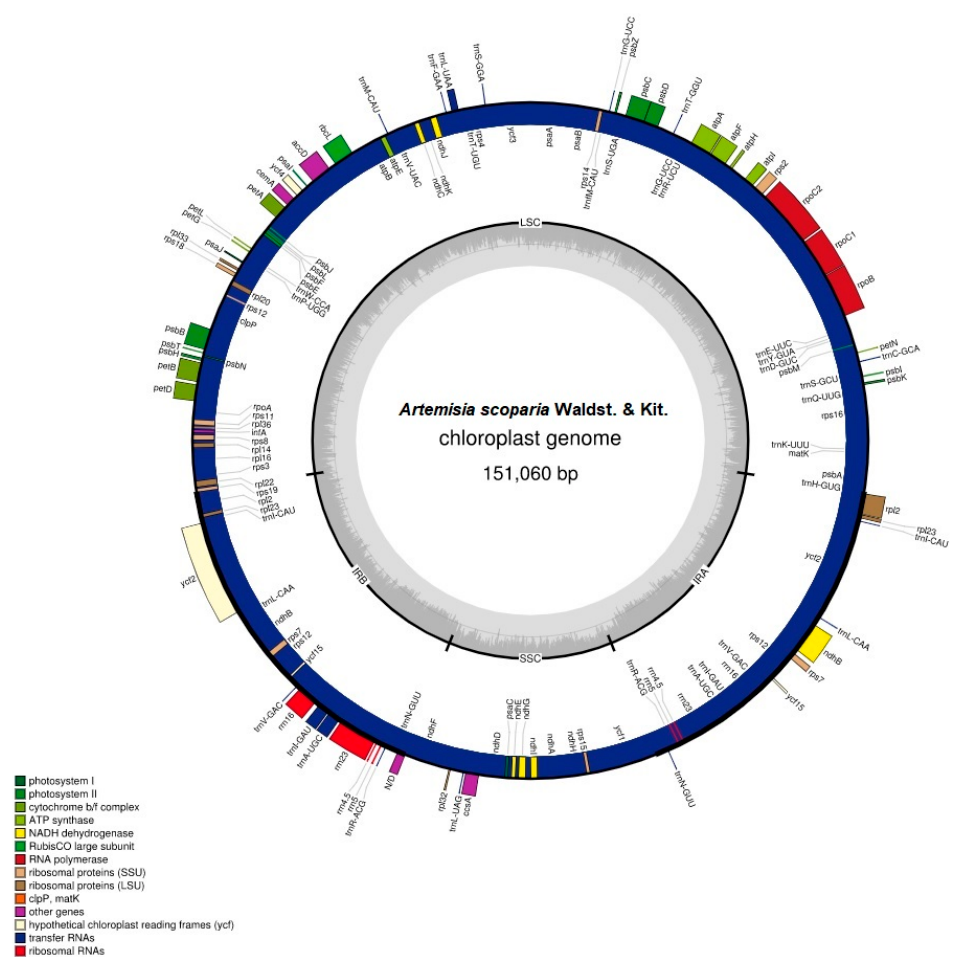
Figure 1. Circular map of the Artemisia scoparia chloroplast genome. The genes present outside of the circle are transcribed anti-clockwise, while those inside the circle are transcribed clockwise. Large single copy (LSC), inverted repeat (IRa, IRb), and small single copy (SSC) regions are indicated. The dashed grey color of the inner circle shows the GC content, whereas the lighter gray color shows the AT content. Color of genes was assigned based on their functions.